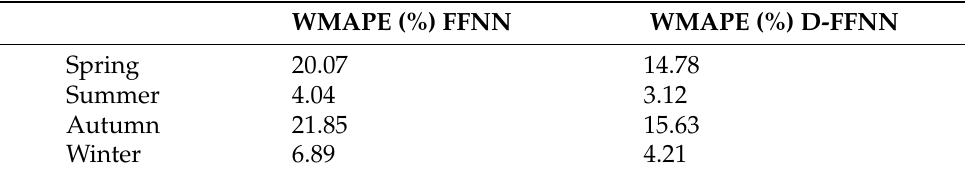
Table 3. WMAPE and RMSE achieved by static and dynamic neural